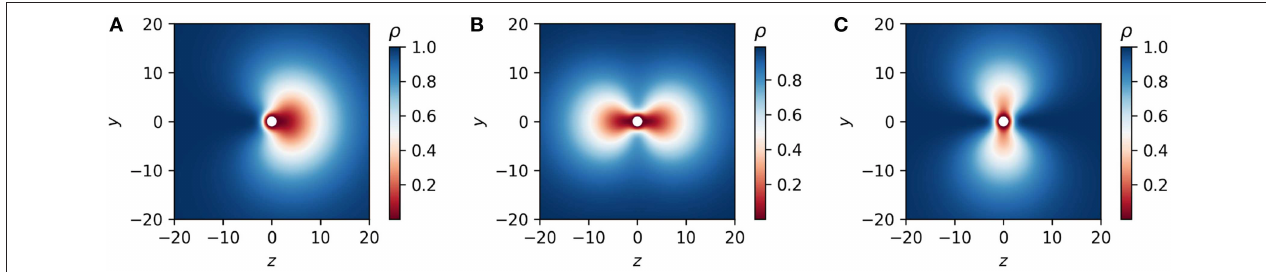
FIGURE 8 | Concentration profile ρ (see Equation 32) next to a dipolar grafted (Janus-like) colloidal particle (A) , next to a quadrupolar back-front grafted colloidal particle (B) , and a quadrupolar waist grafted particle (C) . The length scale of the depletion zone at one hemisphere of the dipolar grafted particle and at the waist (back front) of the quadrupolar grafted particle is fixed at ( d 1 = 1) whereas at the other parts of the particle it is fixed at d = 10.